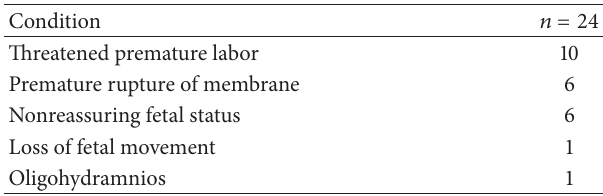
Data are expressed as